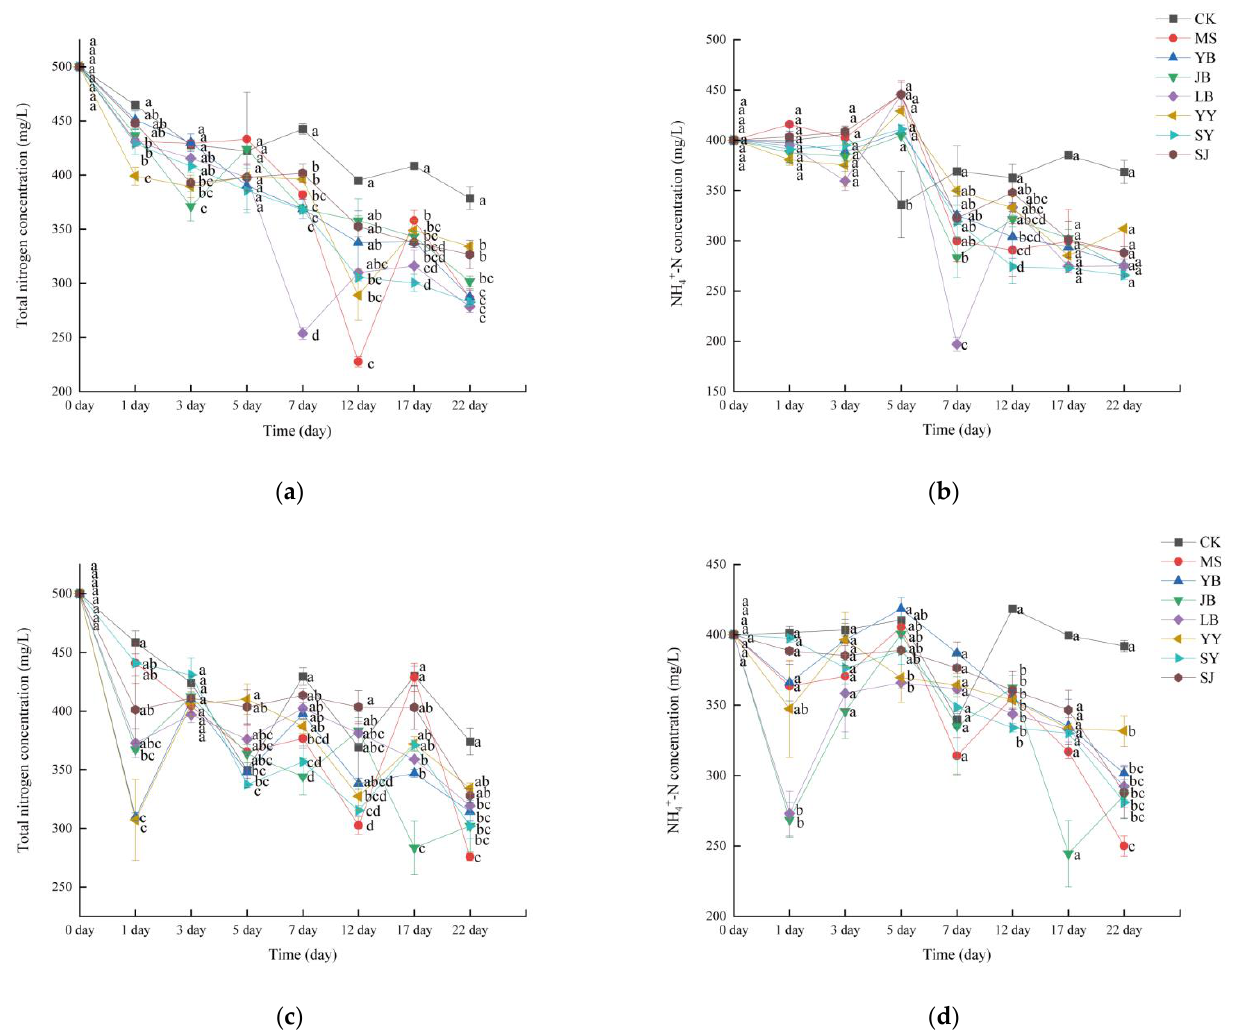
Figure 3. Concentrations of different N forms in the beakers with different O. javanica cultivars at different temperatures. Different letters indicate the significance of the difference of the concentration on the same day. ( a ) Concentrations of TN at room temperature. ( b ) Concentrations of NH 4+ -N at room temperature. ( c ) Concentrations of TN under cold stress. ( d ) Concentrations of NH 4+ -N under cold stress. MS: ‘Meinan Shuiqin’; YB: ‘Yuqi Baiqin’; JB: ‘Jiangyin Baiqin’; LB: ‘Liyang Baiqin’; YY: ‘Yixing Yuanye’; SY: ‘Suzhou Yuanye’; SJ: ‘Suqian Jianye’.